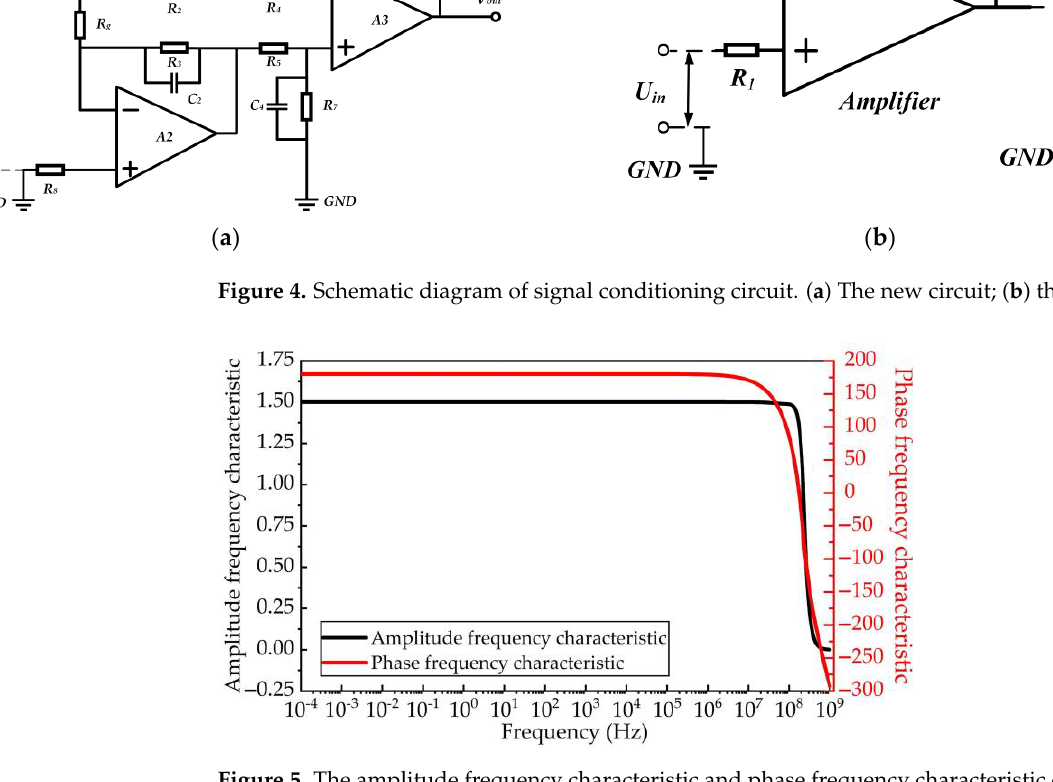
Figure 5. The amplitude frequency characteristic and phase frequency characteristic of signal con- ditioning